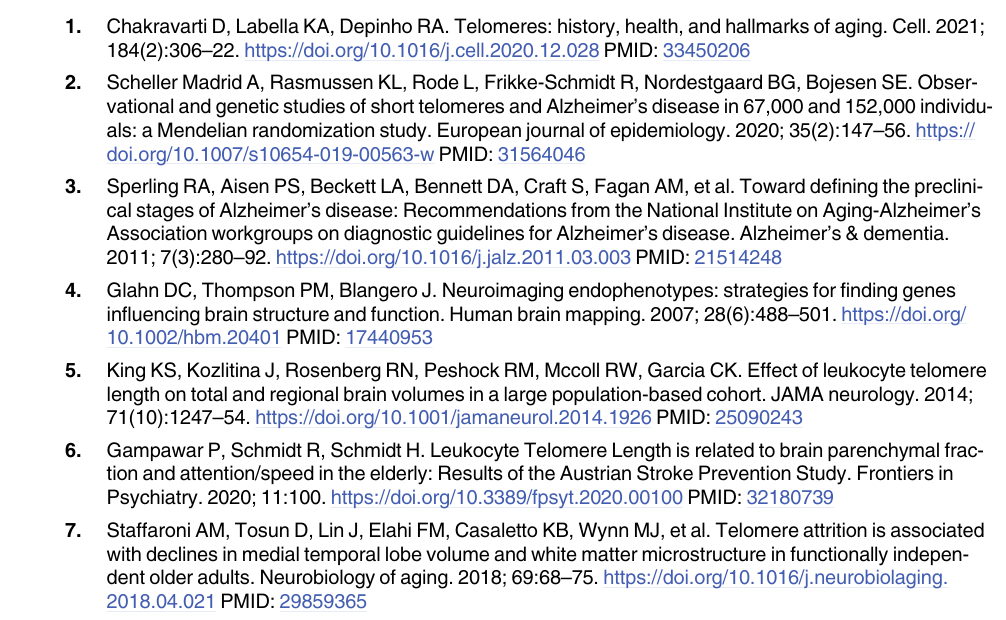
S6 Table. Associations between leucocyte telomere length and cognitive test performance. (XLSX) S1 File. Testing proportional hazards